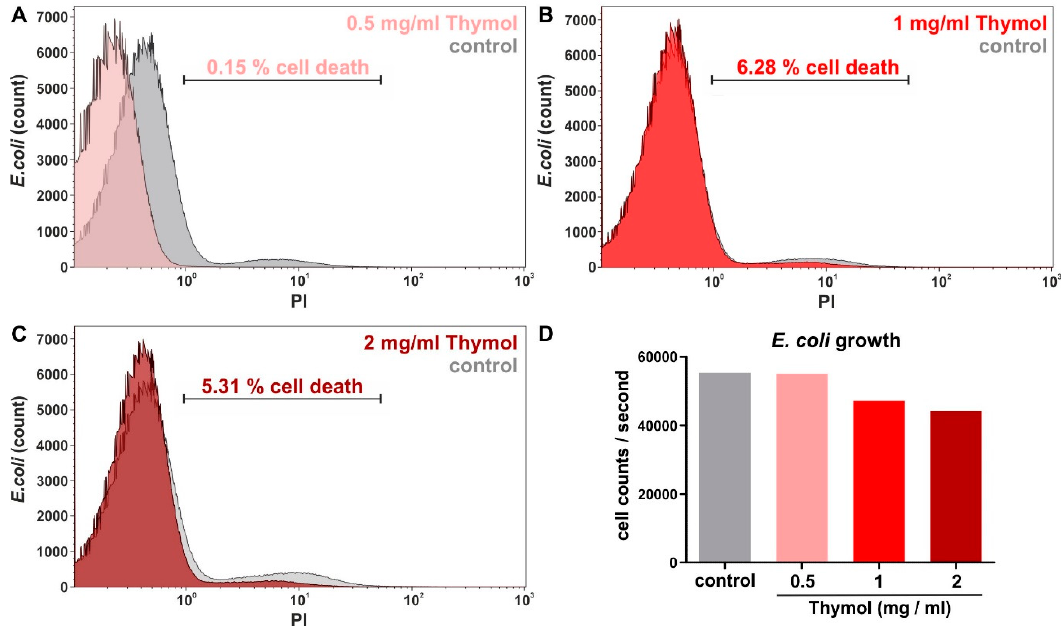
Figure 9. Invasomes encapsulating thymol are not bactericidal against Gram-negative bacteria such as E. coli . ( A – C ) Compared to untreated negative control, treatment of E. coli . with 0.5 mg/mL, 1 mg/mL or 2 mg/mL thymol packaged in invasomes did not result in elevated amounts of cell death. ( D ) Assessment of cell flow revealed no relevant effects of the different concentrations of invasome-encapsulated thymol on the growth of E. coli .